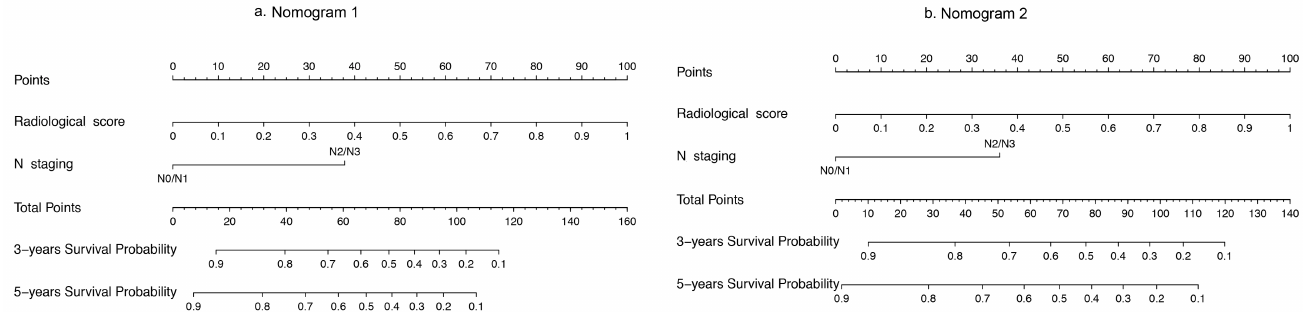
Figure 3. Prognostic nomograms. Probability of 3-year and 5-year disease-free survival of the nomograms developed by Rad-score and nodal staging information. ( a ) Nomogram 1 (with genomics feature selection). ( b ) Nomogram 2 (without genomics feature selection).